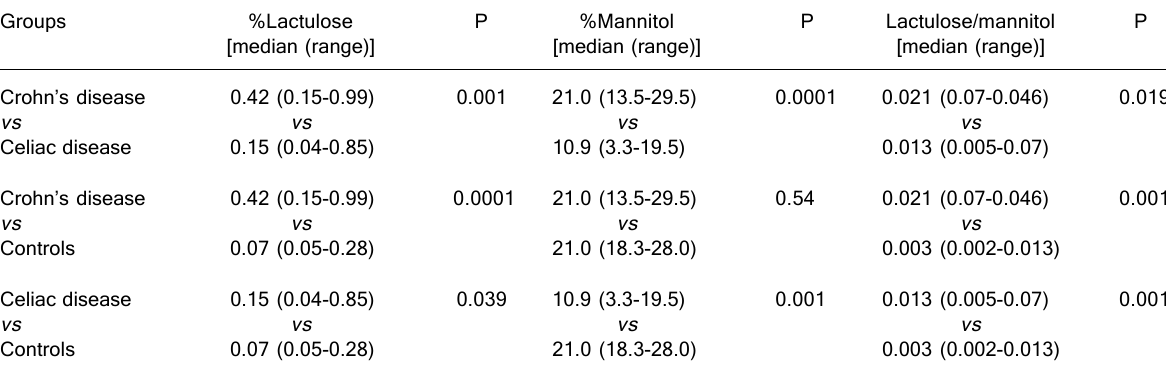
Table 1. Intestinal permeability of Crohn’s disease and celiac disease patients for lactulose and mannitol.